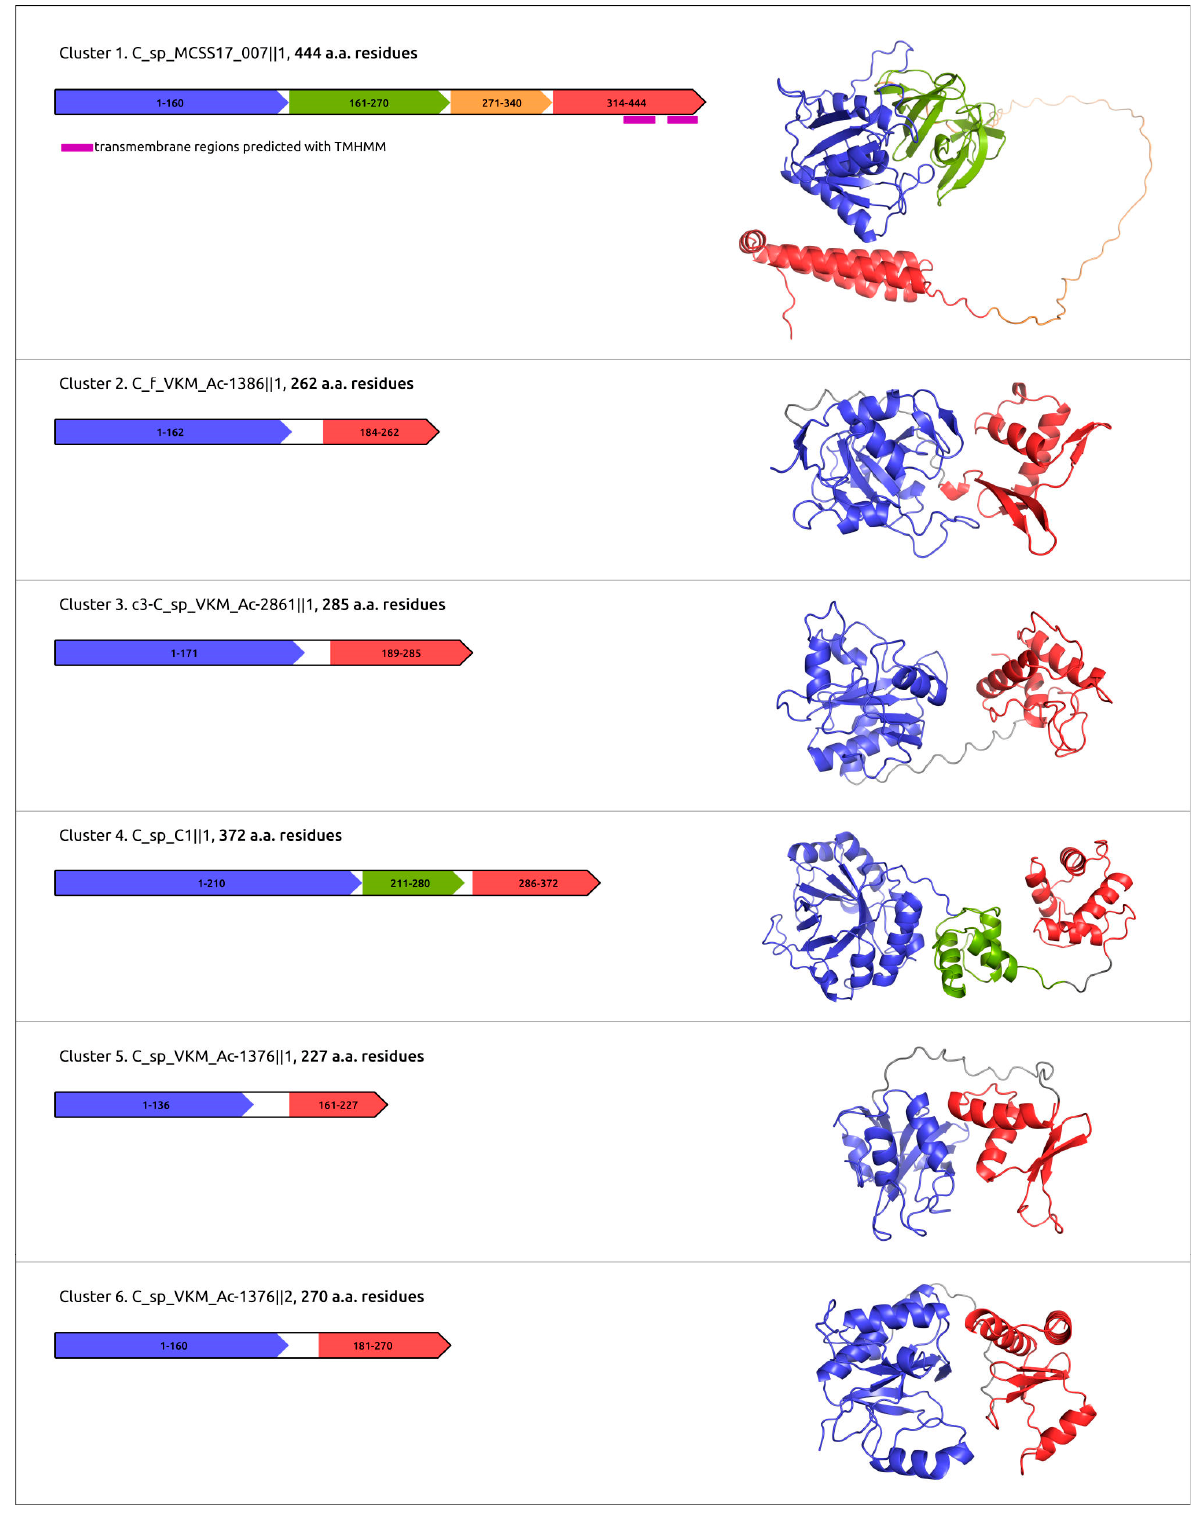
Figure 8. Domain architecture and AlphaFold models of putative endolysins encoded in the putative prophage regions.